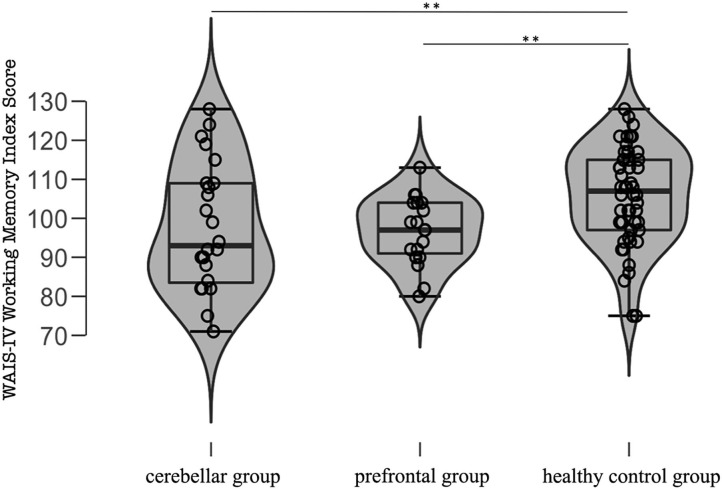
Violin plots, sample size and individual data points of the three groups (cerebellar group; prefrontal group; HC group) of the Weschler Adult Intelligence Scale IV (WAIS-IV) working memory index score. **Significantly different p < 0.05.